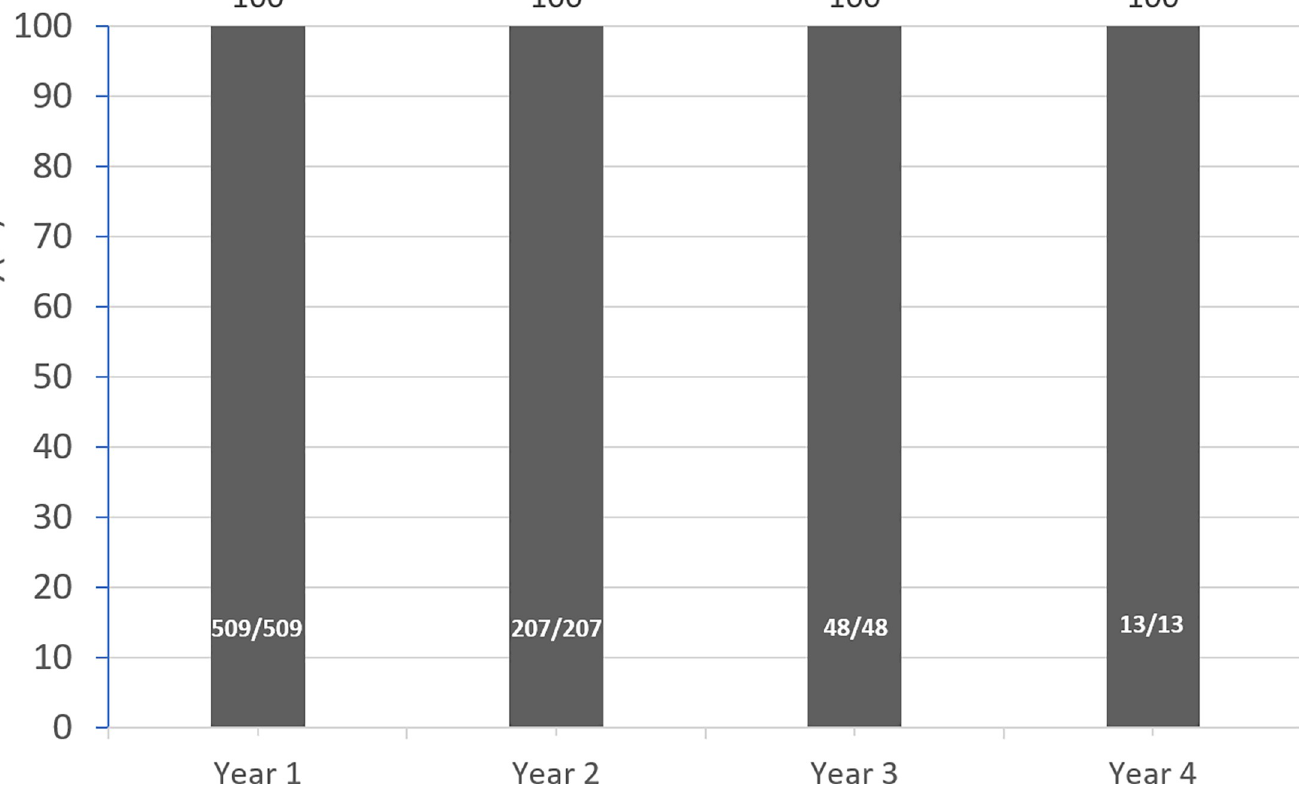
Fig 2. SVR durability beyond SVR24. SVR: sustained virological